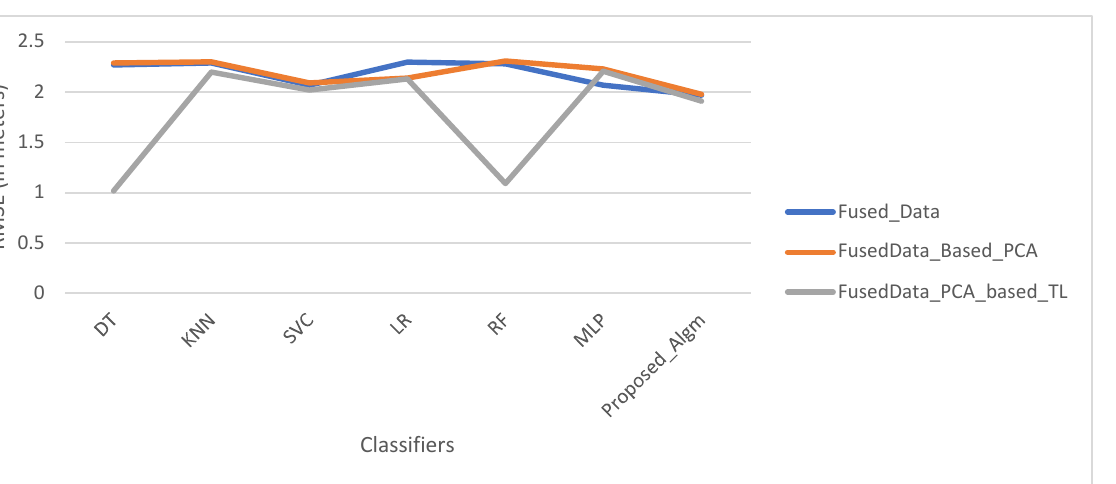
Figure 10. Performance analysis of classifiers applied to indoor parking lots based on fused data of CSI-fingerprints.